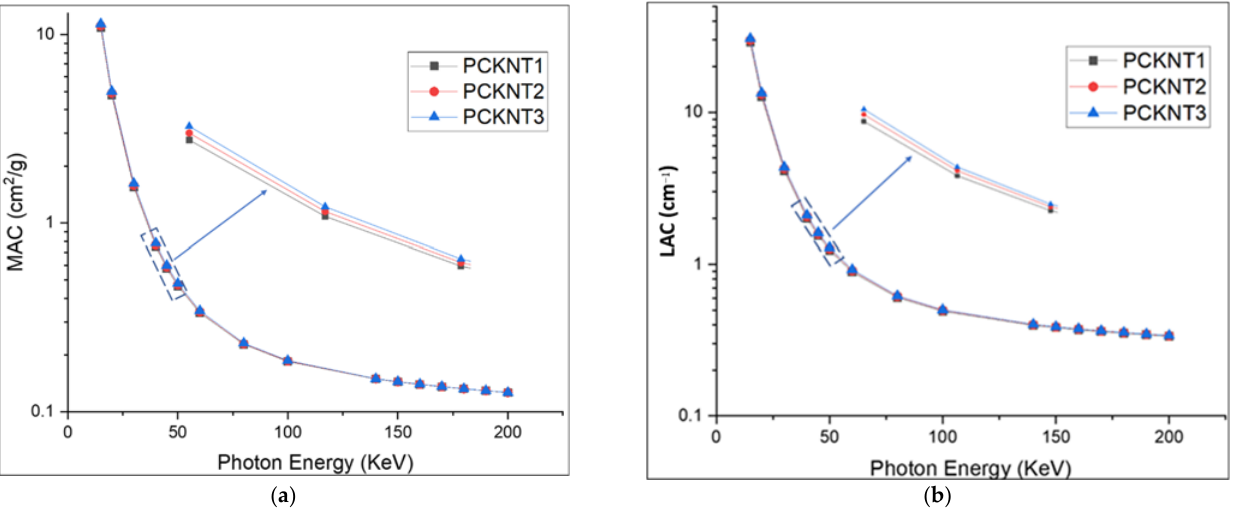
Figure 5. ( a ) The mass attenuation coefficient of prepared glasses; ( b ) the linear attenuation coefficient of prepared glasses. Table 4. Mass and linear attenuation coefficient values for PCKNT glass systems.